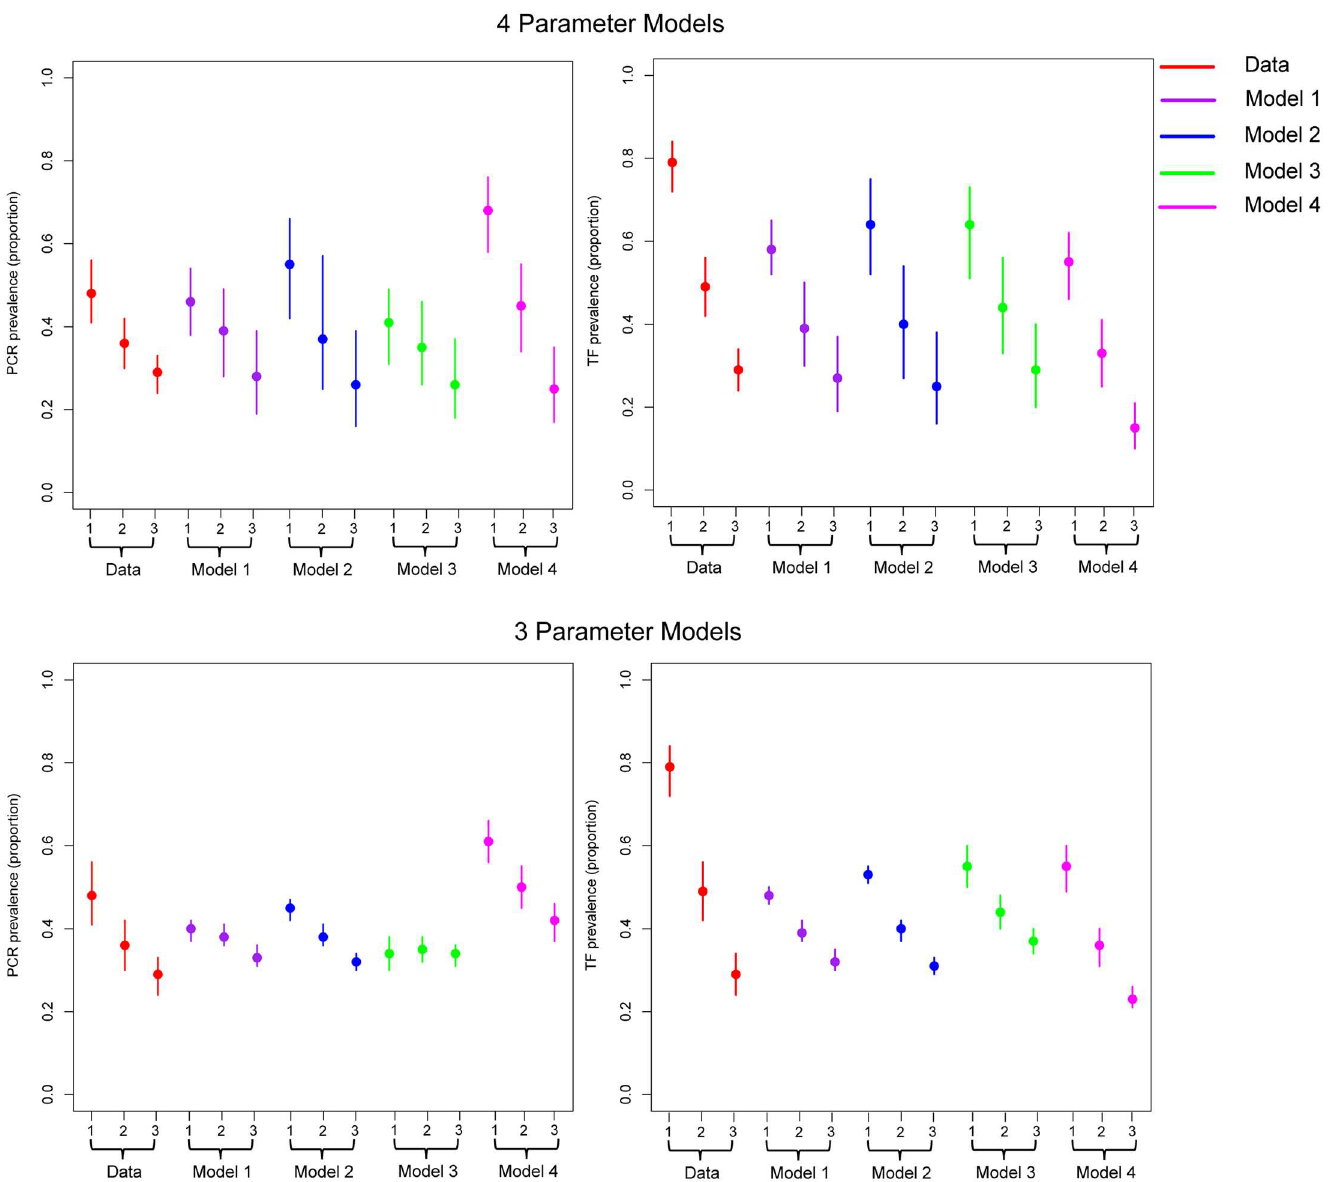
Fig 2. Estimatesfrom the best performing models of the age-specific PCR and TF prevalence. Estimates of age-specific TF and PCR prevalence from statistically the best performing models for each structure evaluated.Data is shown in red, Model 1 results are shown in purple, Model 2 results are shown in blue, Model 3 results are shown in green, and Model 4 results are shown in pink. The first row shows PCR and TF fits from the 4 parameter models. The second row shows PCR and TF fits from the 3 parameter model. Lines aroundeach model’spoint estimate are the 95%